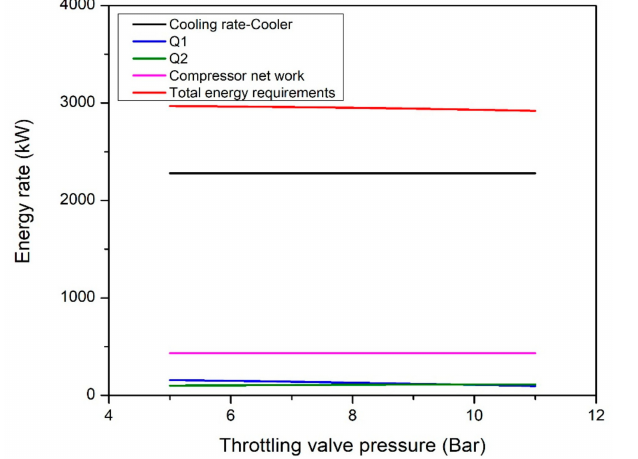
Figure 6. Impact of the compressor discharge pressure on the SV separation unit’s energy requirements.